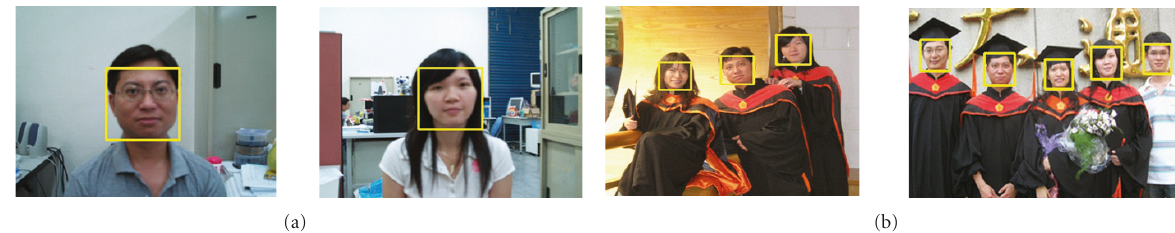
Figure 15: Face detection results for (a) a single face and (b) multifaces in an